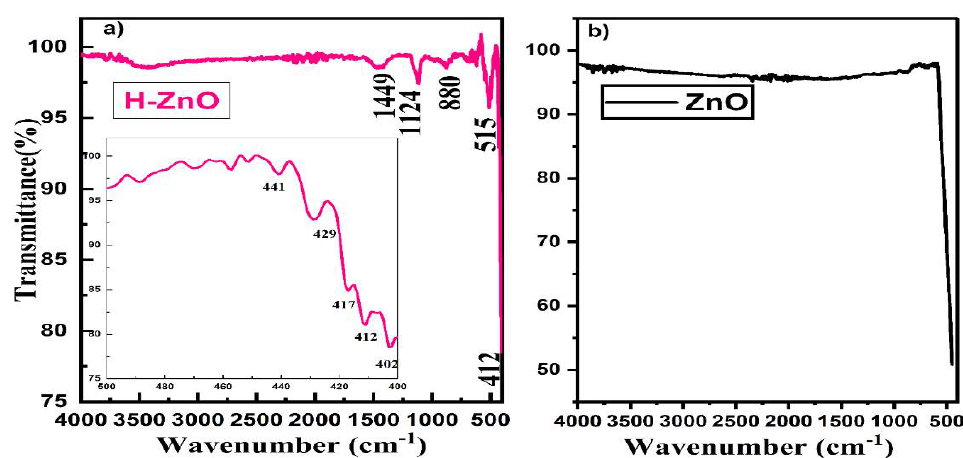
Figure 2. FTIR spectra of bare ZnO ( a ) and H-ZnO ( b ) nanoparticles.